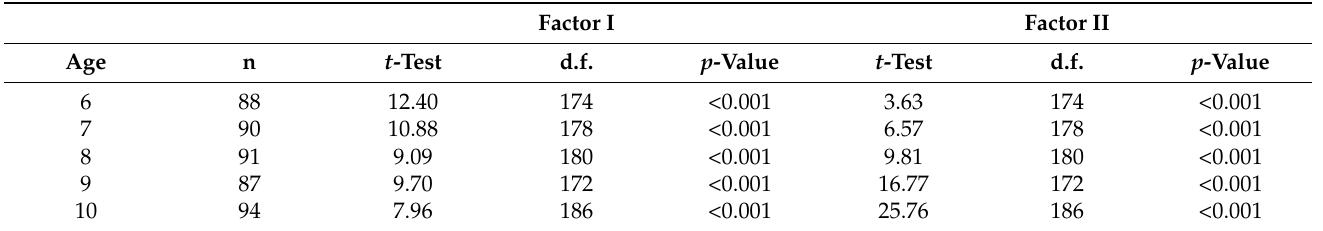
Table 5. Factor I and Factor II: t -test comparing differences between RPCM mean scores in the standard condition and in the ZPD condition.